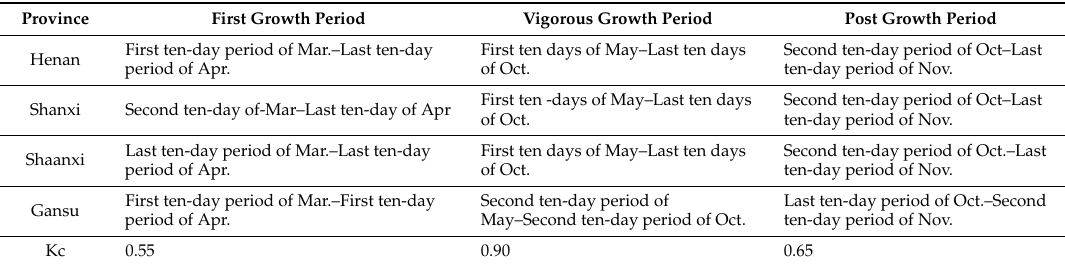
Table 2. Growth stages and crop coefficients of apple